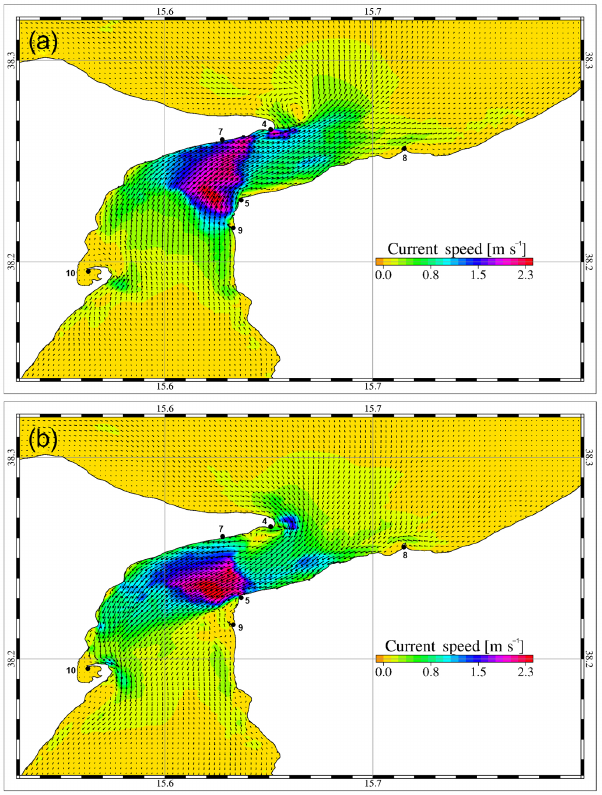
Figure 2. Vertically averaged water currents fields computed at the maximum flow during ebb phase (a) and flood phase (b) of spring tides.